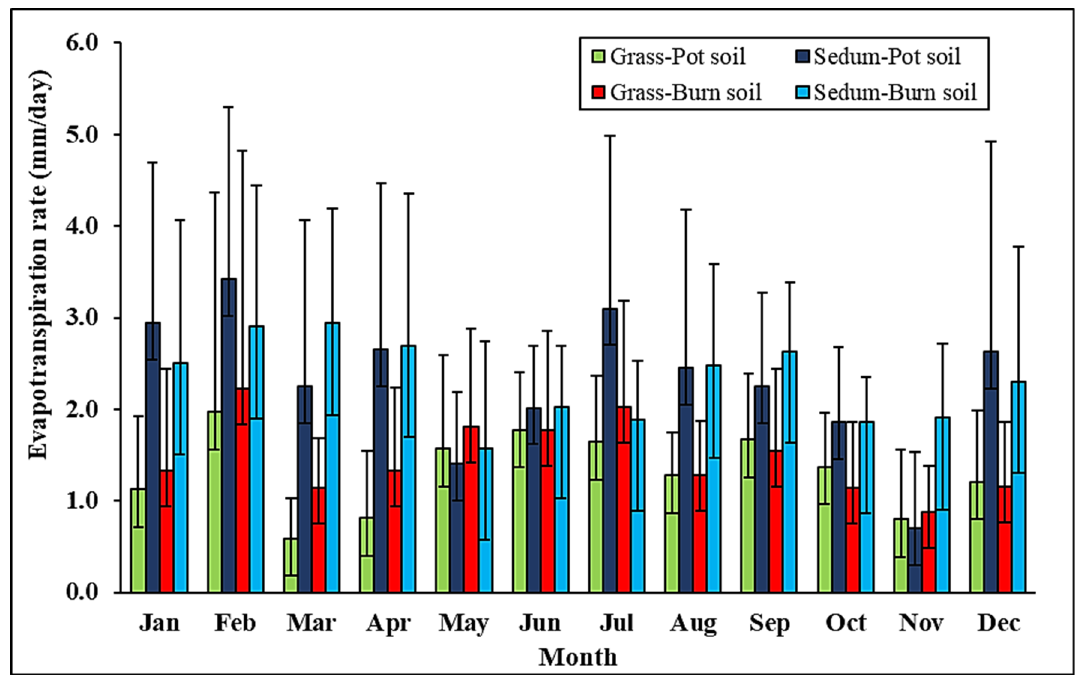
Figure 4. Monthly averaged evapotranspiration (ET) rates for different green roof plant species and substrate types. Table 2. Correlations between environmental parameters and ET rates of green roofs. Evapotranspiration (ET) Rates Pot Soil Burn Soil Parameter Grass Sedum Grass Sedum Temperature 0.66 ** 0.71 ** 0.65 ** 0.65 ** Relative humidity − 0.59 ** Solar radiation Wind